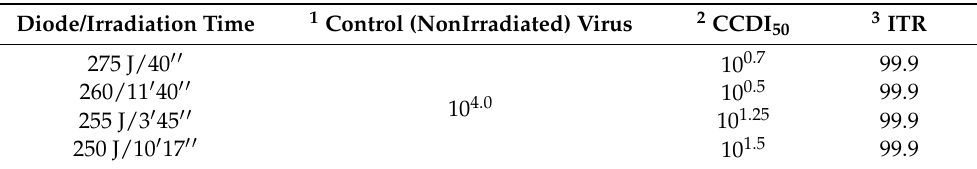
Table 2. Human coronavirus (HCoV-OC43) infectious titer reduction using the UV-C diodes. Analyses based on cytopathic effect (CPE) observation.